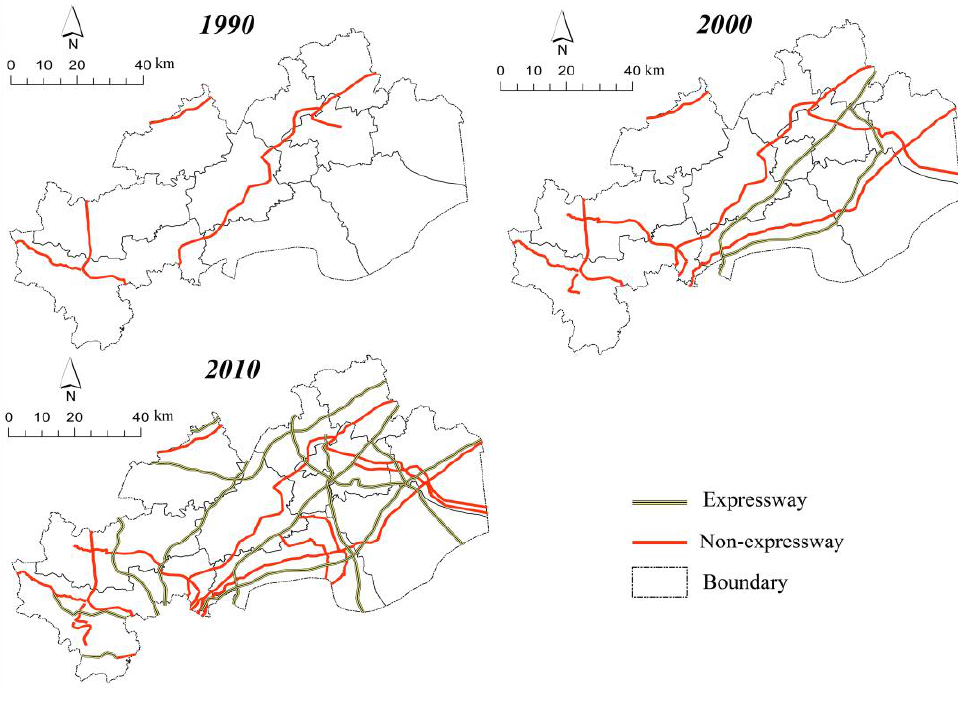
Figure 3. Spatial distribution of highways in 1990, 2000 and 2010.